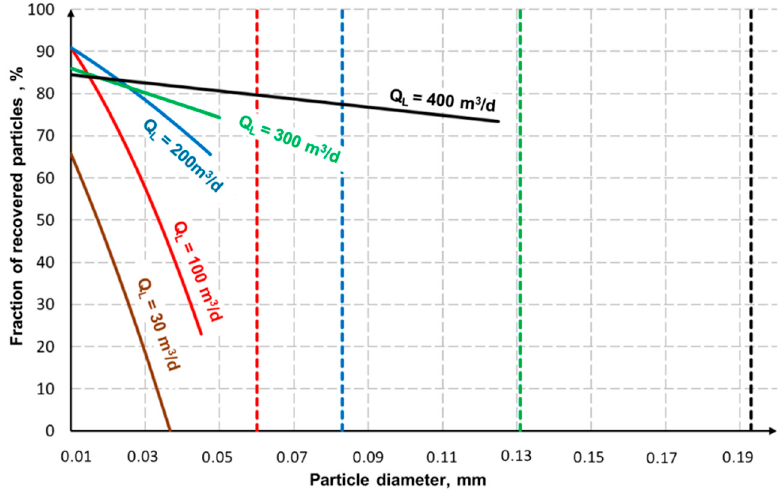
Figure 7. Quality of solids particles recovery by fractions at various well flow rates.